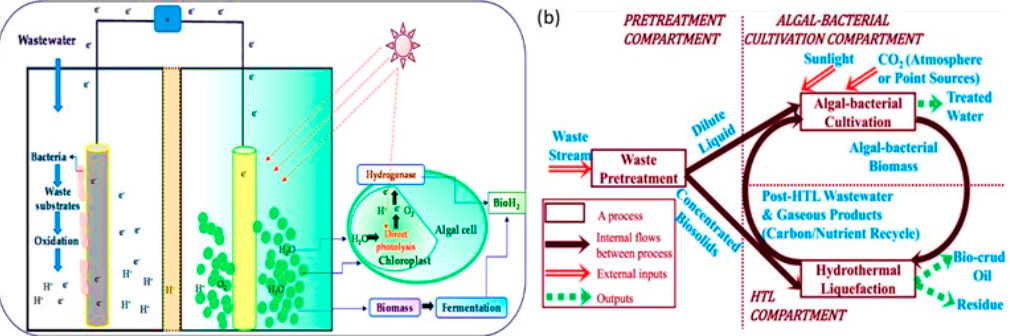
Figure 11. ( a ) Simplified schematic of the Environment-Enhancing Energy process for integrated wastewater treatment and biofuel production. ( b ) Microalgal-based microbial cells-based wastewater treatment and bioH2 production [102]. Reprinted/adapted with permission from Ref. [102]. 2022, Elsevier B.V”.